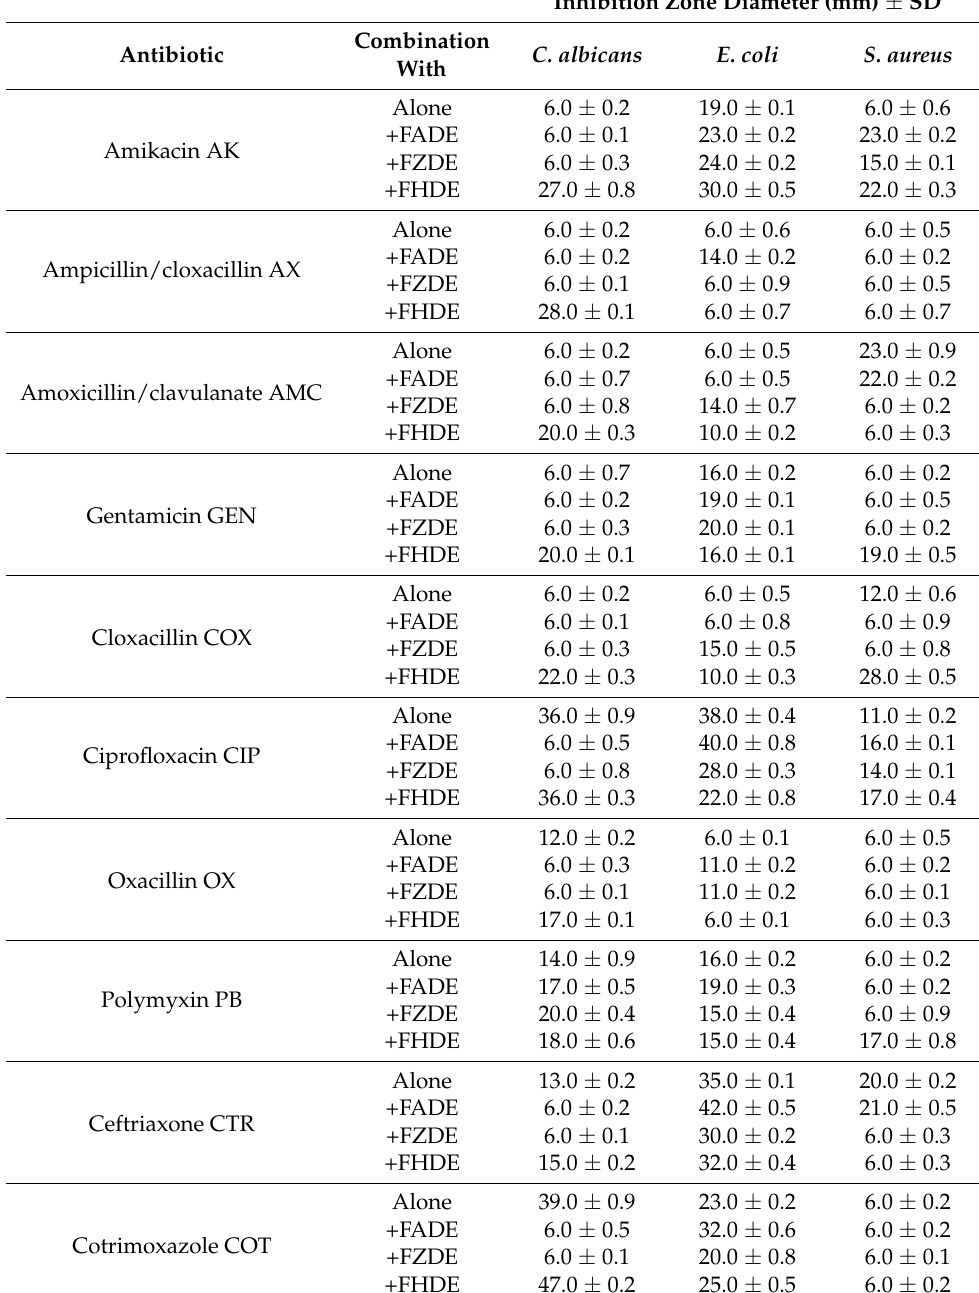
Table 7. Effects of combinations of date extract with commonly used